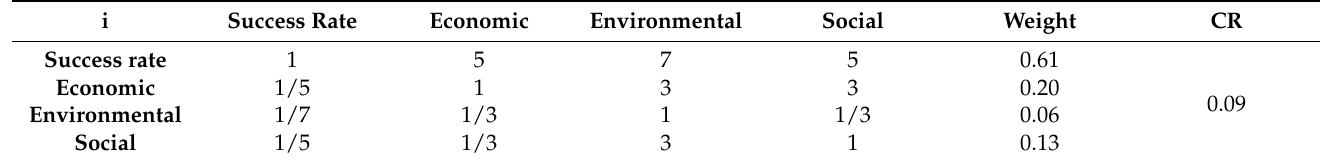
Table 8. Pairwise comparison matrix of criteria.